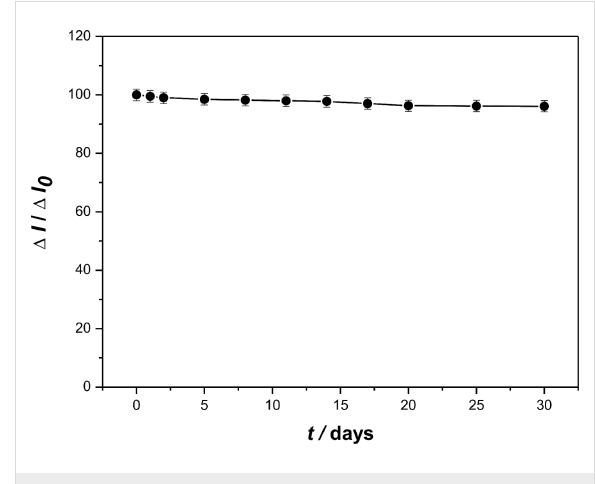
Figure 10: Storage stability of the laccase – Nafion–ECNFs/GCE in 0.2 M acetate buffer (pH 4.0) at 4